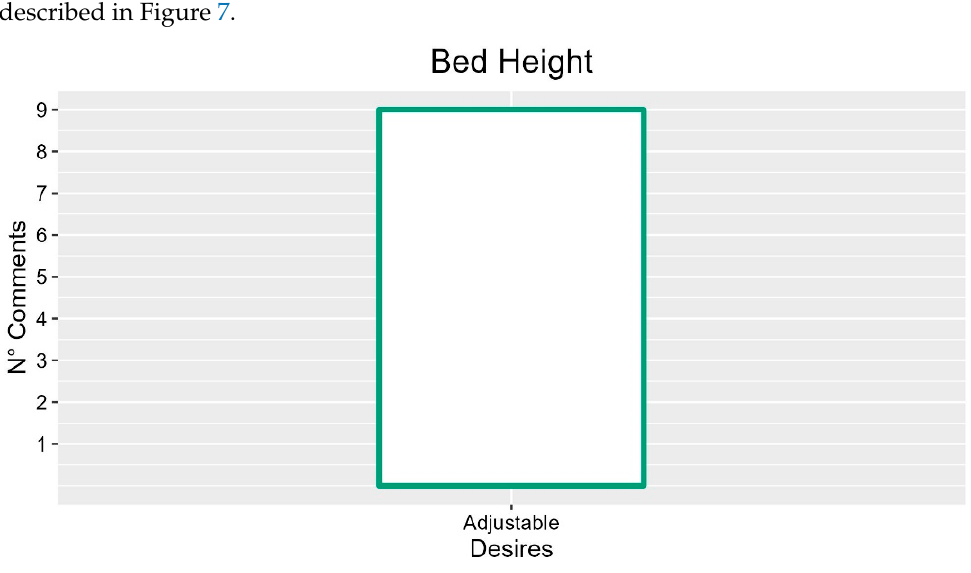
Figure 6. Graphical representation of desires with more occurrences for the Accessories theme.